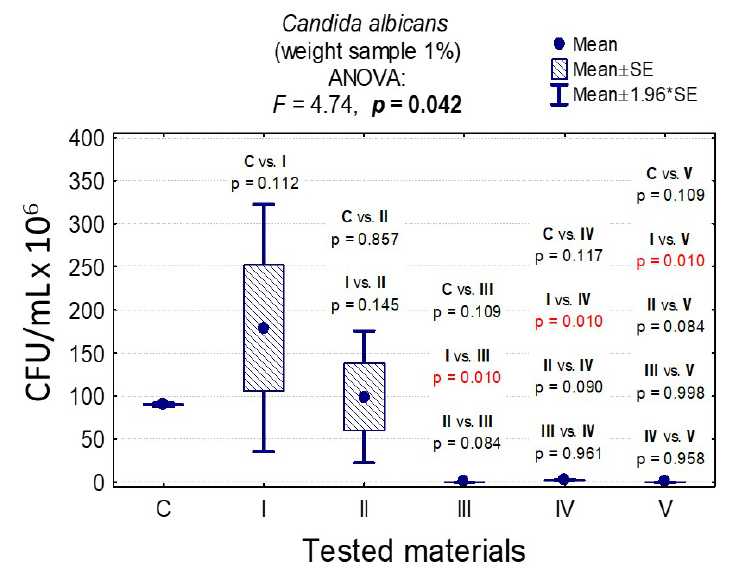
Figure 7. Average CFU / mL values and standard deviation (M ± SD) for Candida albicans after contact with the tested materials (C—growth control, I—nHAp, II—Cu 2 + -doped nHAp, III—nHAp with the addition of ozonated olive oil, IV—nHAp doped with Cu 2 + and loaded with ozonated olive oil, V—ozonated olive oil) for weights of 1% and results of the analysis of variance (ANOVA) and multiple comparisons by a post-hoc test. Incubation took 24 h.